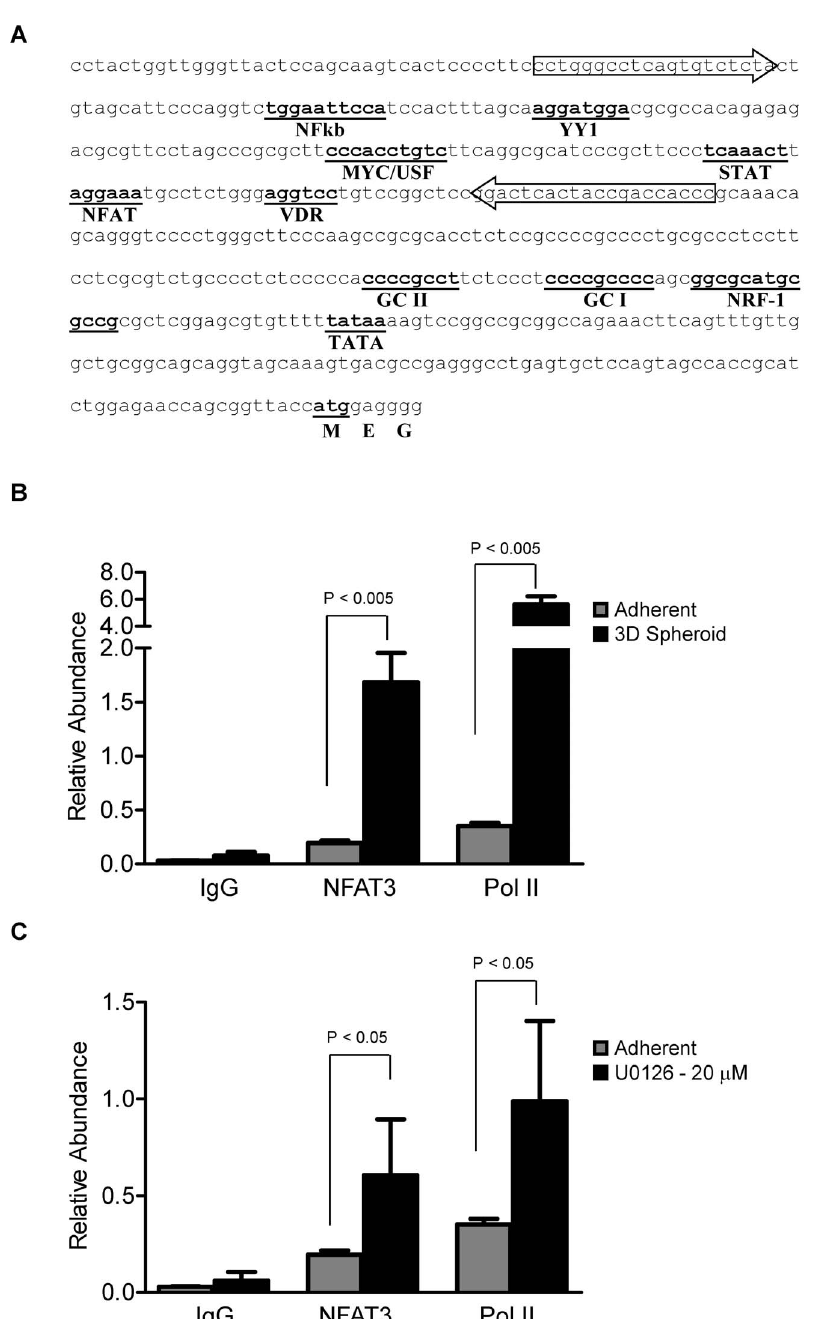
Fig. 8. NFAT3 protein binds CXCR4 promoter. HeyA8 cells were cultured as monolayer and as 3D spheroids (100,000 cells per spheroid) as described in materials and methods. ( A ) CXCR4 gene sequence according to GeneBank accession number AF005058. Regions with putative transcriptional factor binding consensus sequences are underlined and in bold. The block arrows indicate real-time PCR primers used for the chromatin immunoprecipitation analysis. ( B ) Chromatin immunoprecipitation of adherent HeyA8 cells and 3D spheroid showed significant (p , 0.005) increase in relative abundance of NFAT3 and Pol II on the CXCR4 promoter. ( C ) Similar to 3D spheroids, adherent cells treated with 20 m M of U0126 showed significant (p , 0.05) increases in relative abundance of NFAT3 and PolII on the CXCR4 promoter. Average values were derived from 2 independent IPs with qPCRs for each IP performed in duplicate (n 5